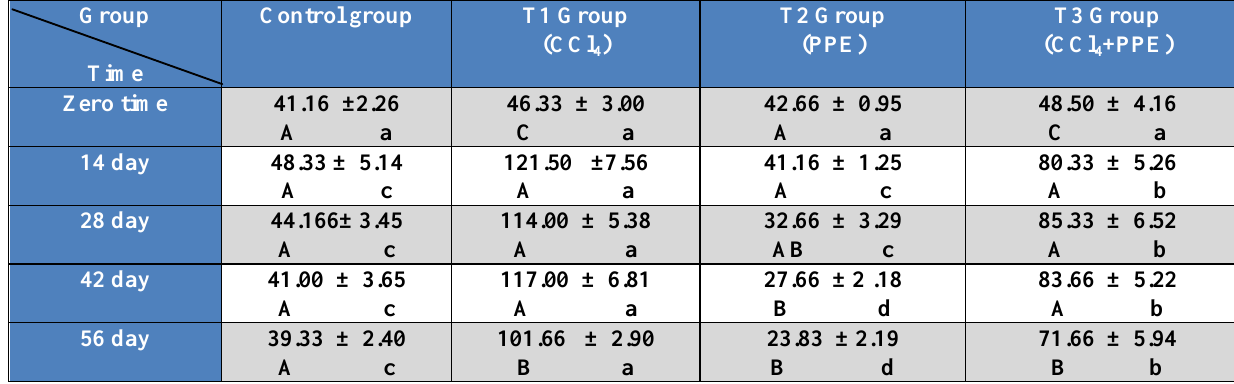
Table , 3: Effect of CCl4, (PPE) and (PPE+ CCl4) on total serum cholesterol (mg / dl ) in adult male rabbits. M ± S.E. (n = 6).